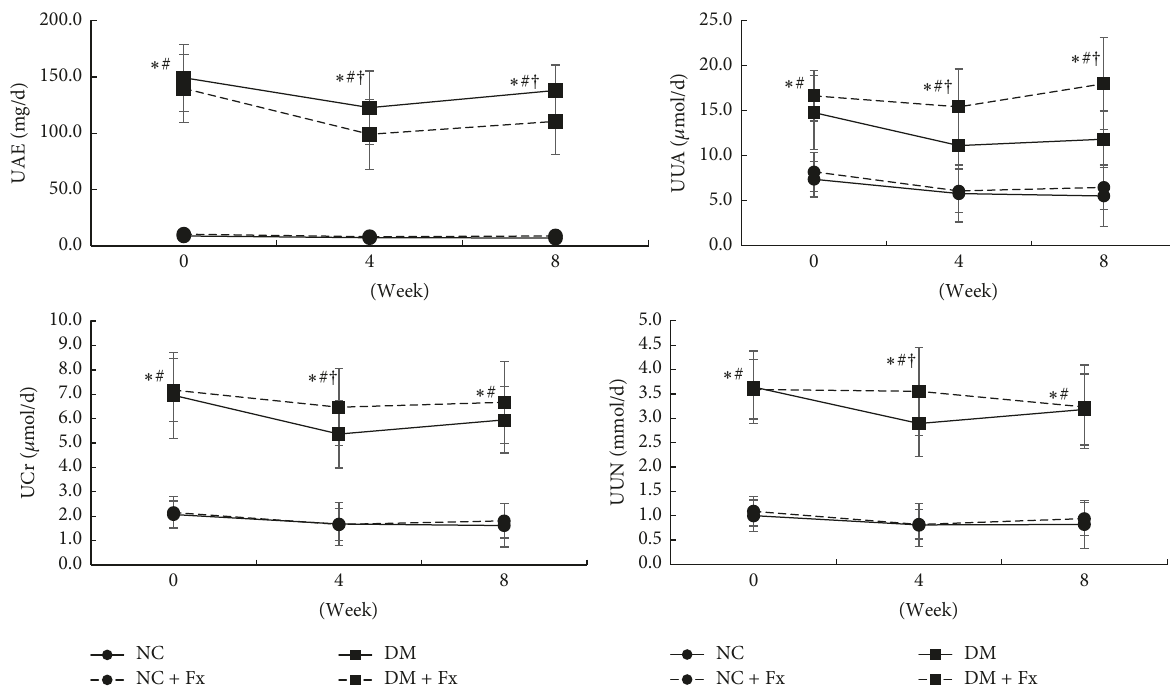
Figure 4: Time course of daily urinary excretions among the four rat groups. The circle with solid and dashed lines represents NC and NC + Fx groups, respectively, while the block symbol with solid and dashed lines shows data of DM and DM + Fx groups, respectively. Data are expressed as mean ± SD. Statistical significance ( 푃 < 0.05 ) was labeled as ∗ , #, and † correspondingly, when the DM + Fx group was compared with NC, NC + Fx, and DM groups.